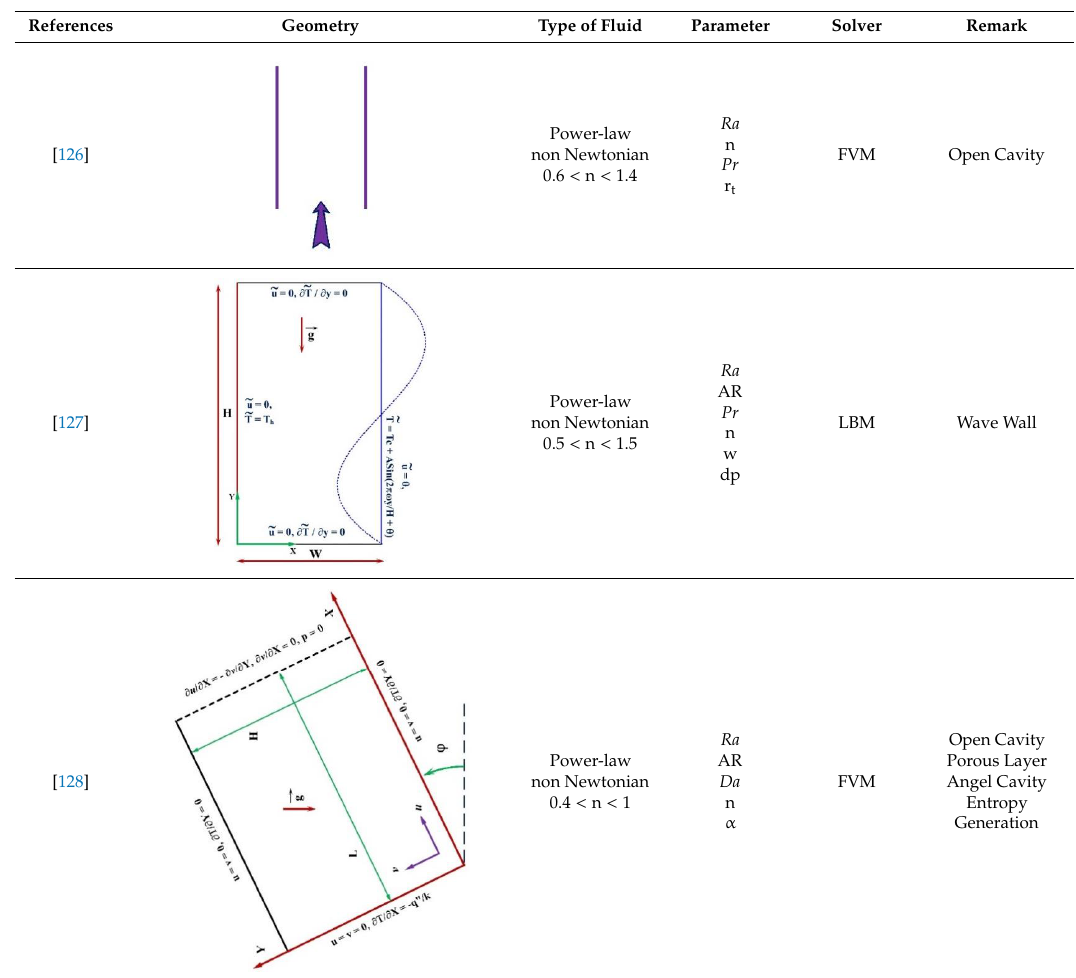
Table 7. Brief of articles about non-Newtonian fluids within enclosures.